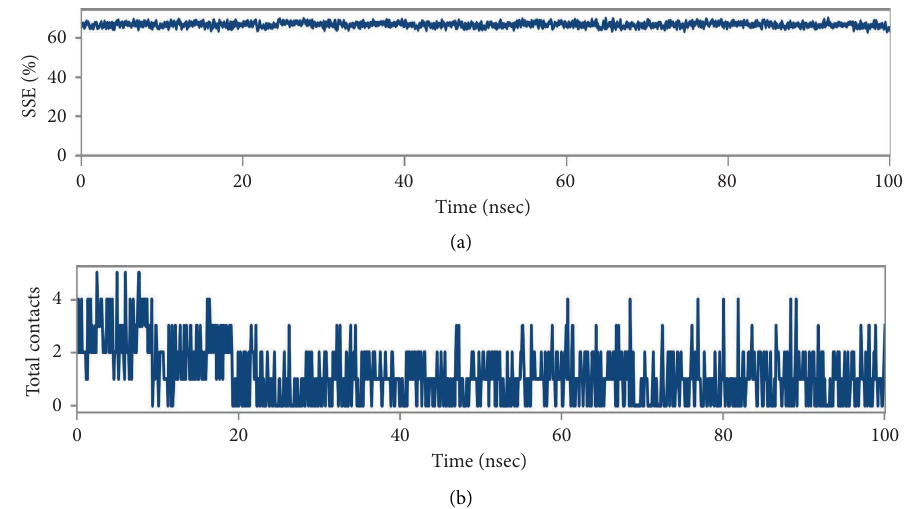
Figure 7: Variations in the (a) SSE of the BSA–cuminaldehyde during the simulation and (b) the total number of contacts between BSA and cuminaldehyde over 100ns simulation